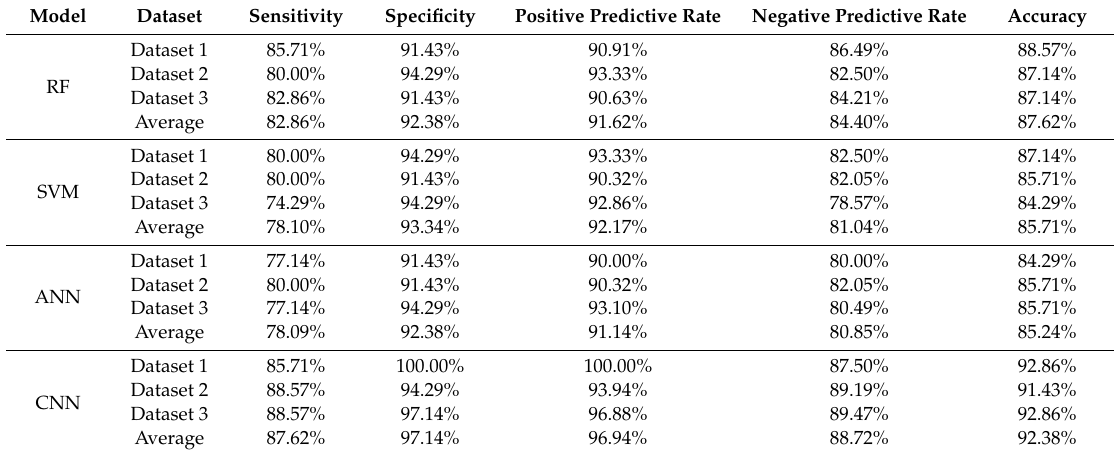
Table 3. Classification performance of machine learning